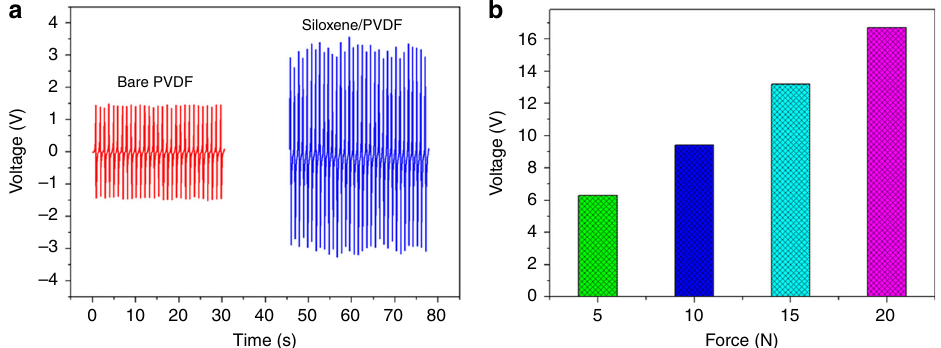
Fig. 4 Mechanical energy-harvesting properties of siloxene – PVDF piezo fi bers. a Voltage outputs of the bare PVDF and siloxene – PVDF piezo fi bers subjected to an applied compressive force of 5 N. b Effect of applied compressive forces on the voltage output characteristics of siloxene – PVDF piezo fi bers subjected to various levels of applied compressive forces.